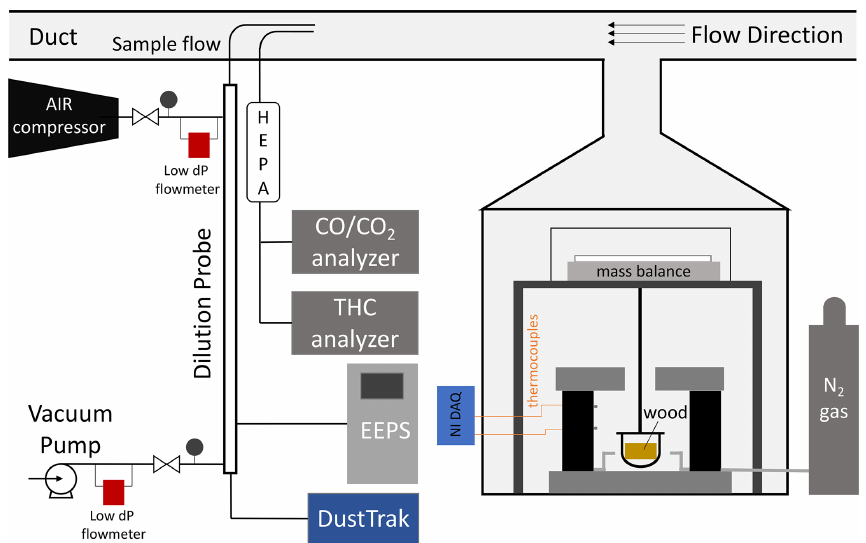
Figure 1. Experimental setup of the pyrolysis reactor and the sampling gases and